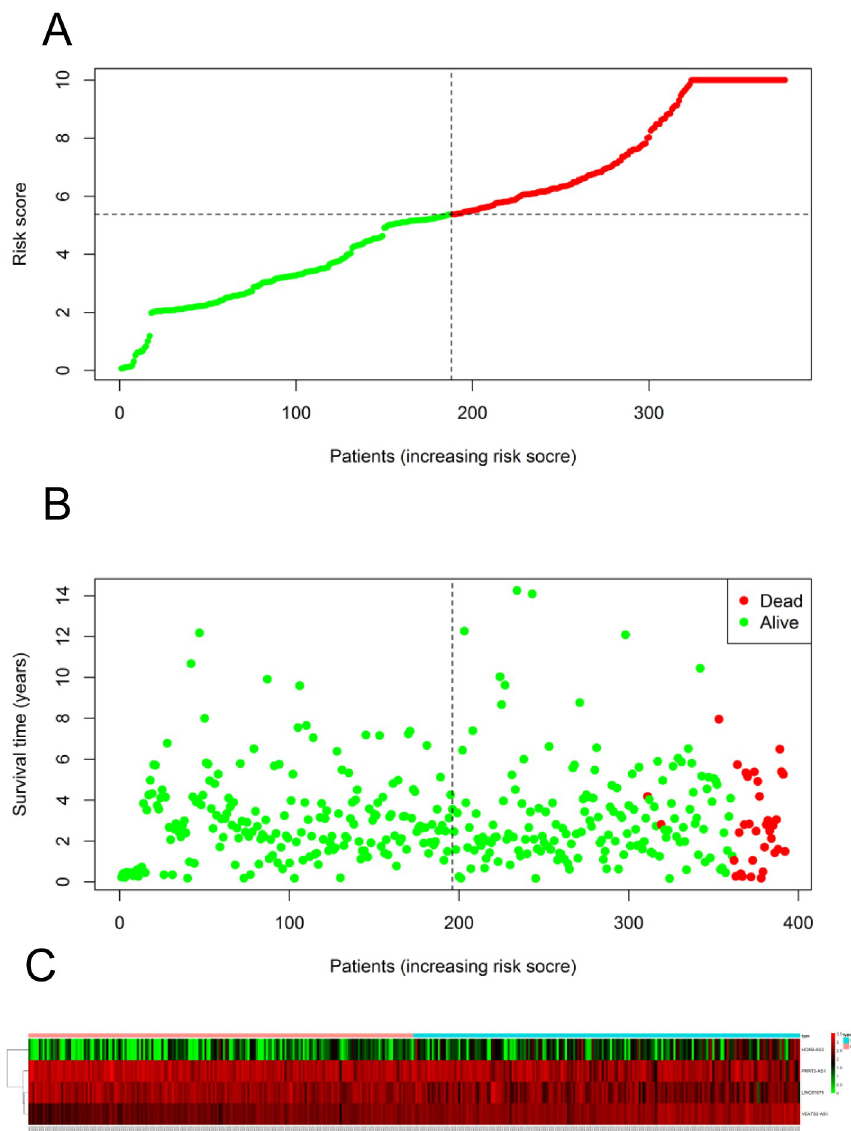
Fig 5. Predictive power of the model for prognosis in PCa patients. (A) Distribution of patient risk score. (B) Survival time of PCa patients.(C) Heat maps of the four lncRNAs included in the prognostic model. The vertical dotted black line represents the optimal threshold for classifying cases into high—and low-risk